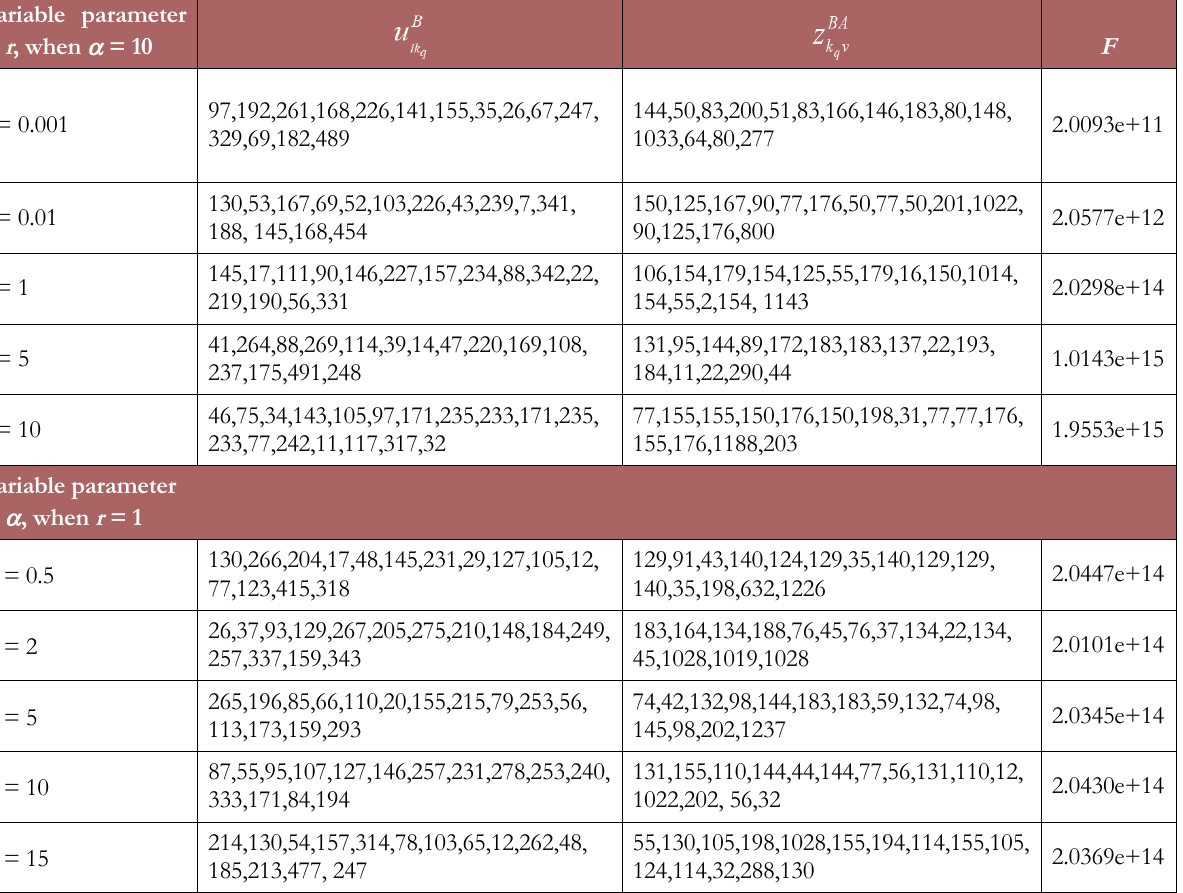
Table 3. Experimental results in the southern